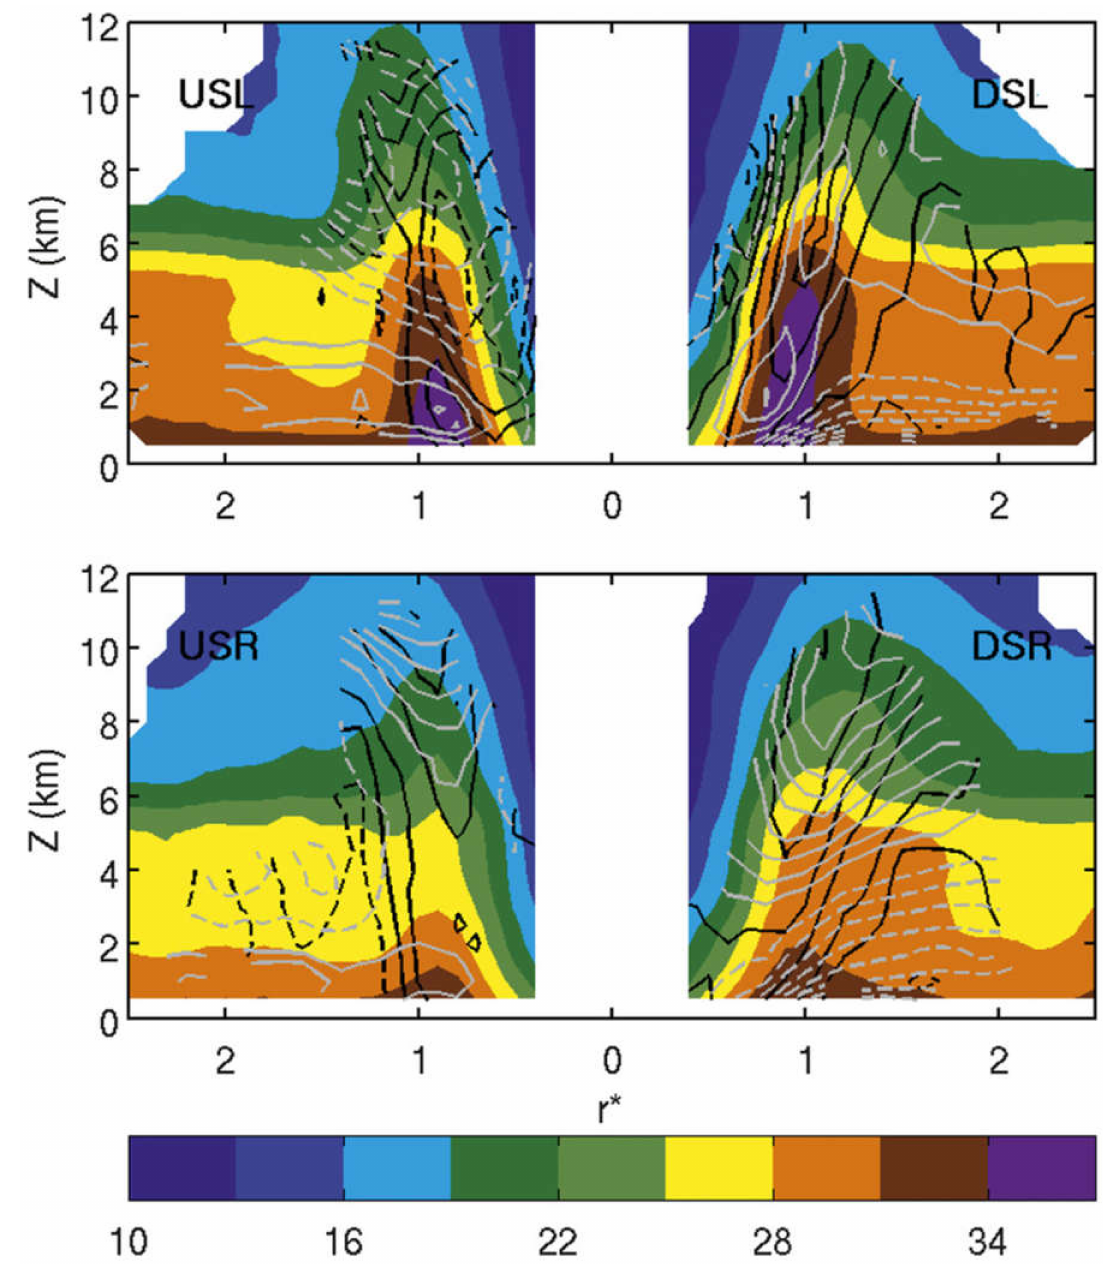
Figure 3. Quadrant-average cross sections of shear-relative composite reflectivity (dBZ, shaded), vertical velocity (m s − 1 , black contours), and radial velocity (m s − 1 , gray contours) for cases with peak winds >31 m s − 1 and 850–200 hPa vertical shear >7 m s − 1 . The quadrants are arranged such that the shear vector points to the right of the page. Regions of negative vertical motion are highlighted by the 0 and − 0.25 m s − 1 dashed black contours. Contours of positive vertical motion (solid black) are drawn at 0.25, 0.5, 1, 1.5, 2, and 2.5 m s − 1 . The contour interval for radial inflow (dashed gray) and outflow (solid gray) is 1 m s − 1 (zero contour omitted). The radial coordinate r* represents the radius normalized bythe RMWat 2 km altitude. Adapted from